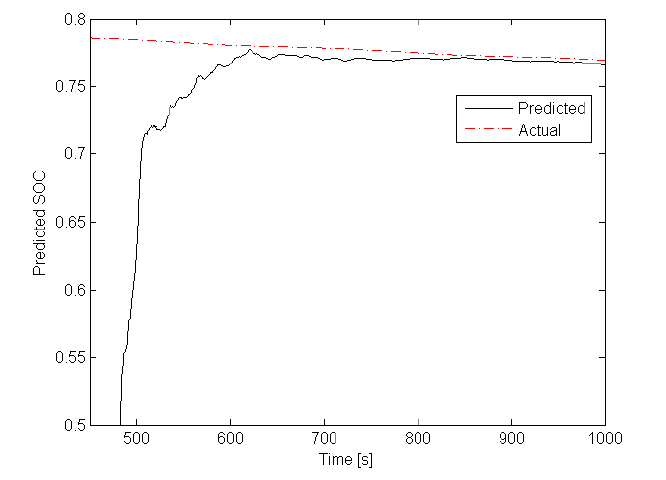
Figure 12. SOC and its prediction—initial prediction